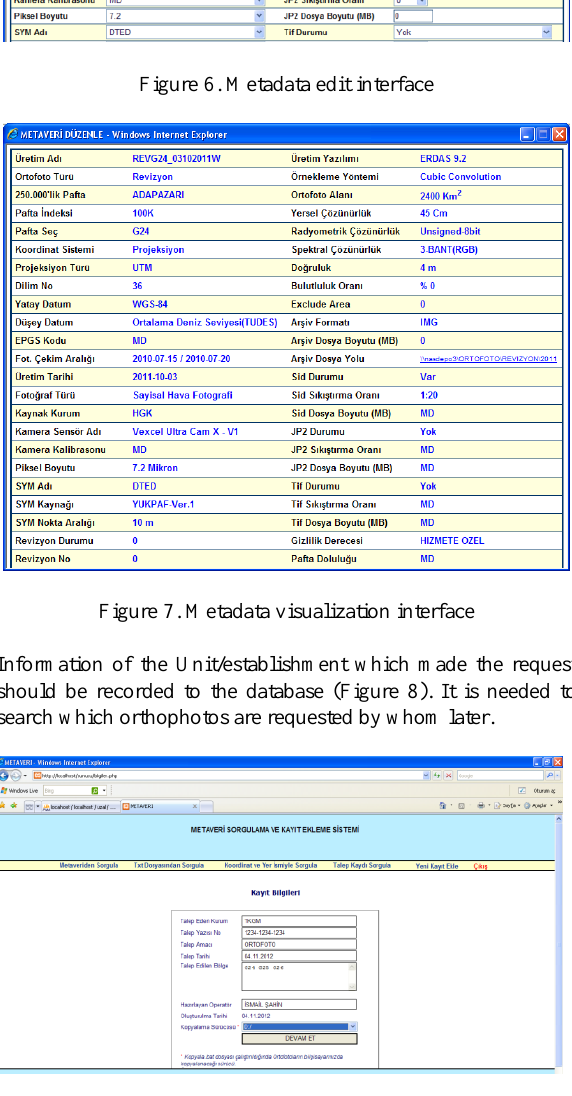
Figure 8. Recorded information interface belonging to the requested metadata